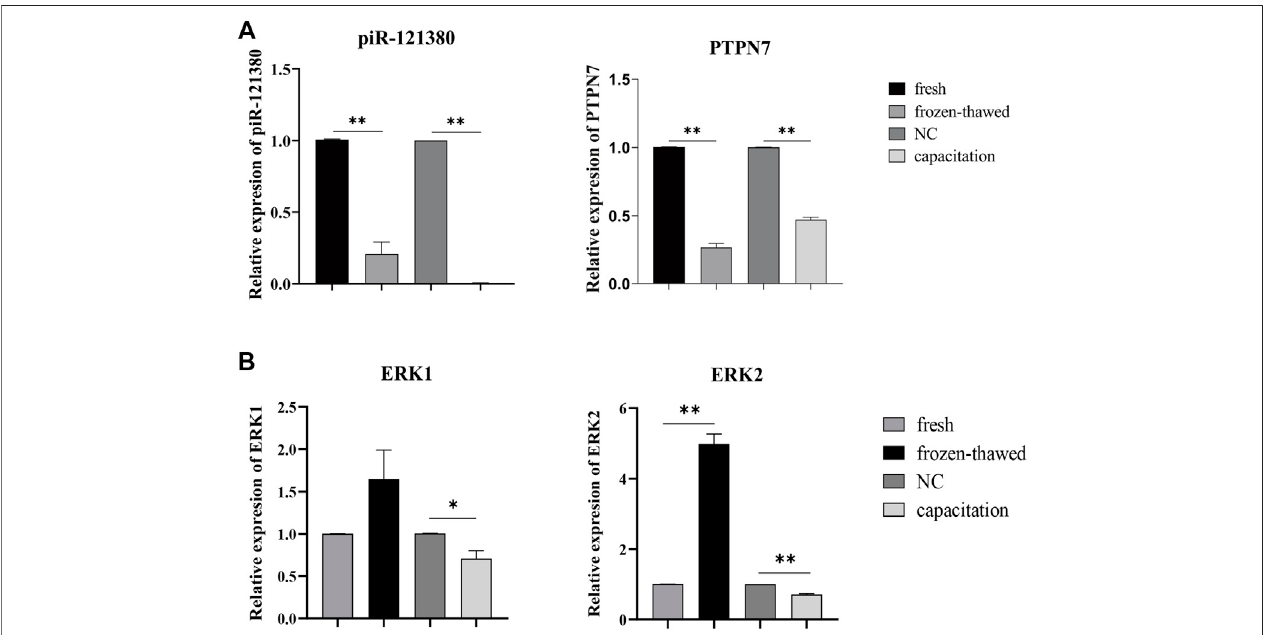
FIGURE 2 | (A) The expression levels of piR-121380 and PTPN7 in fresh, frozen – thawed, and capacitated sperm. ** p < 0.01. (B) The expression levels of ERK1 and ERK2 in fresh, frozen – thawed, and capacitated sperm. ** p < 0.01. * p < 0.05. The data are representative of at least three independent experiments (mean ± SEM).